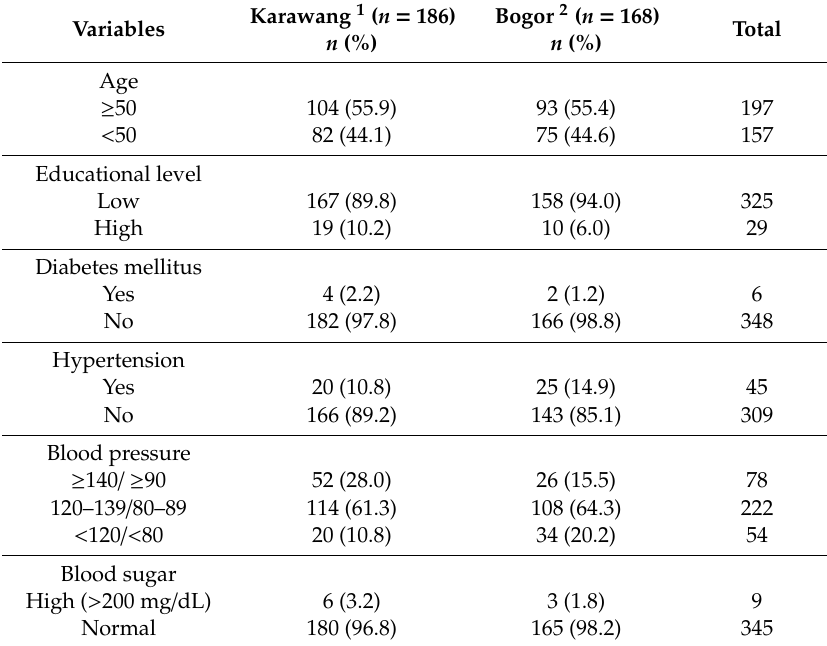
Table 1. Demographic factors of male farmers in Karawang and Bogor in West Java.